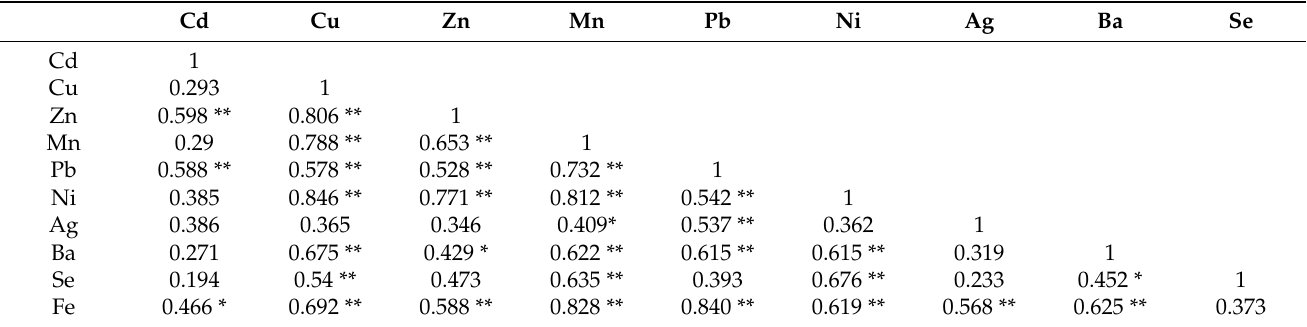
Table 3. Correlation matrix of trace elements in the Han River